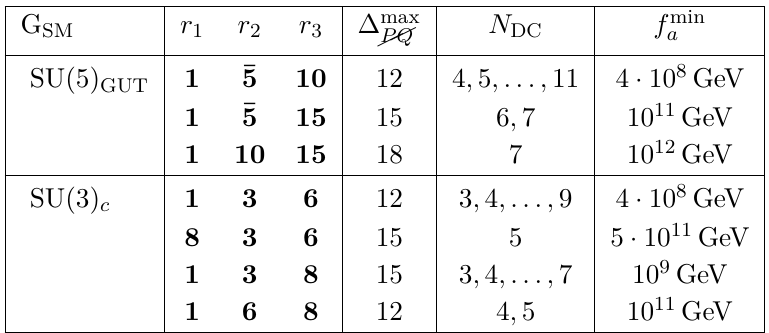
Table 5 . Choices of the representations defined in table 4 allowed by the constraints of section 2.1. Additional viable models are obtained by conjugating the representation r except for models in the last two rows. The last two columns report, respectively, the allowed values of N and the smallest allowed value of f DC